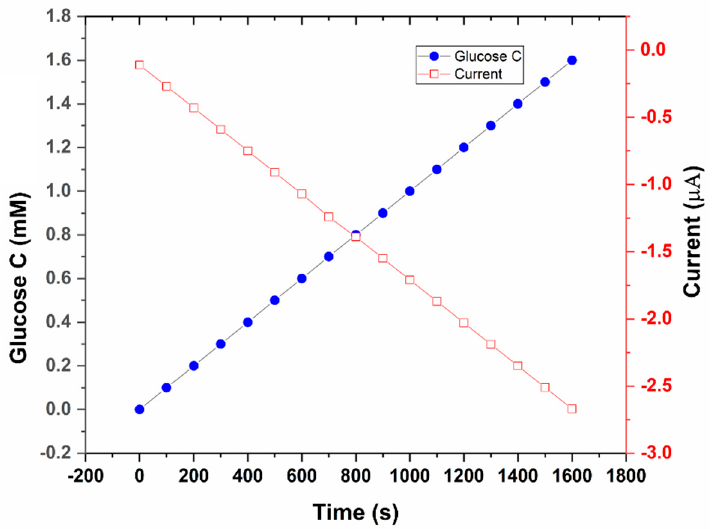
Figure 5. The linearity of the amperometric response of the glucose sensor at − 0.1 V (w.r.t the Ag/AgCl reference electrode) at different glucose concentrations (0 mM~1.6 mM, in 0.01 M PBS so- lution).